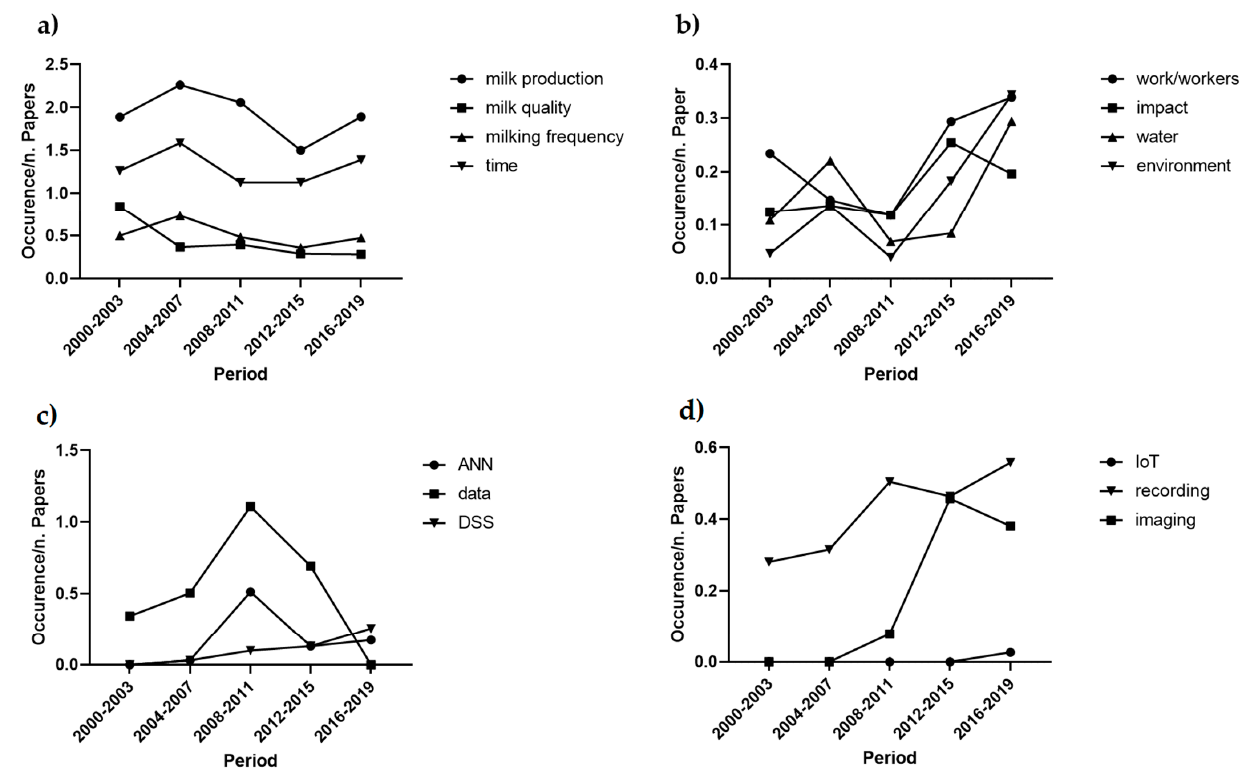
Figure 5. Papers: course of the most representative subjects of clusters “Process” and “Technology” from 2000 to 2019. ( a ) tendencies of the production process; ( b ) tendencies of the production sustainability; ( c ) the shift from data to models and decision support (ANN = Artificial Neural Networks; DSS = Decision Support Systems); ( d ) tendencies of new technologies (IoT = Internet of Things).